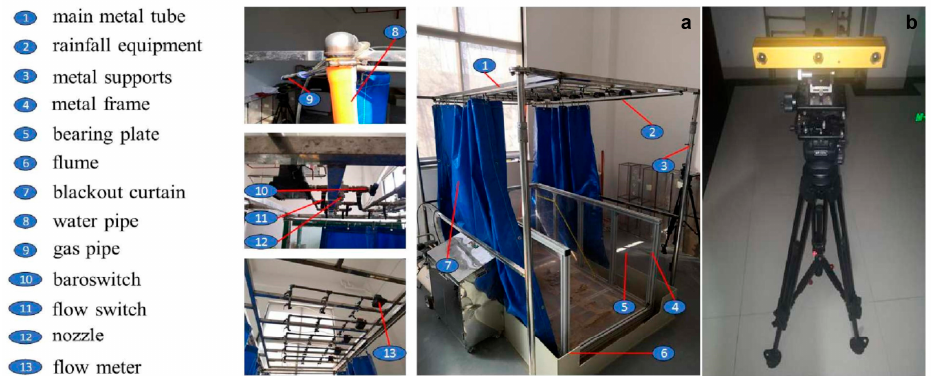
Figure 1. Physical experiment system. ( a ) Rainfall system and ( b ) trinocular stereo camera.